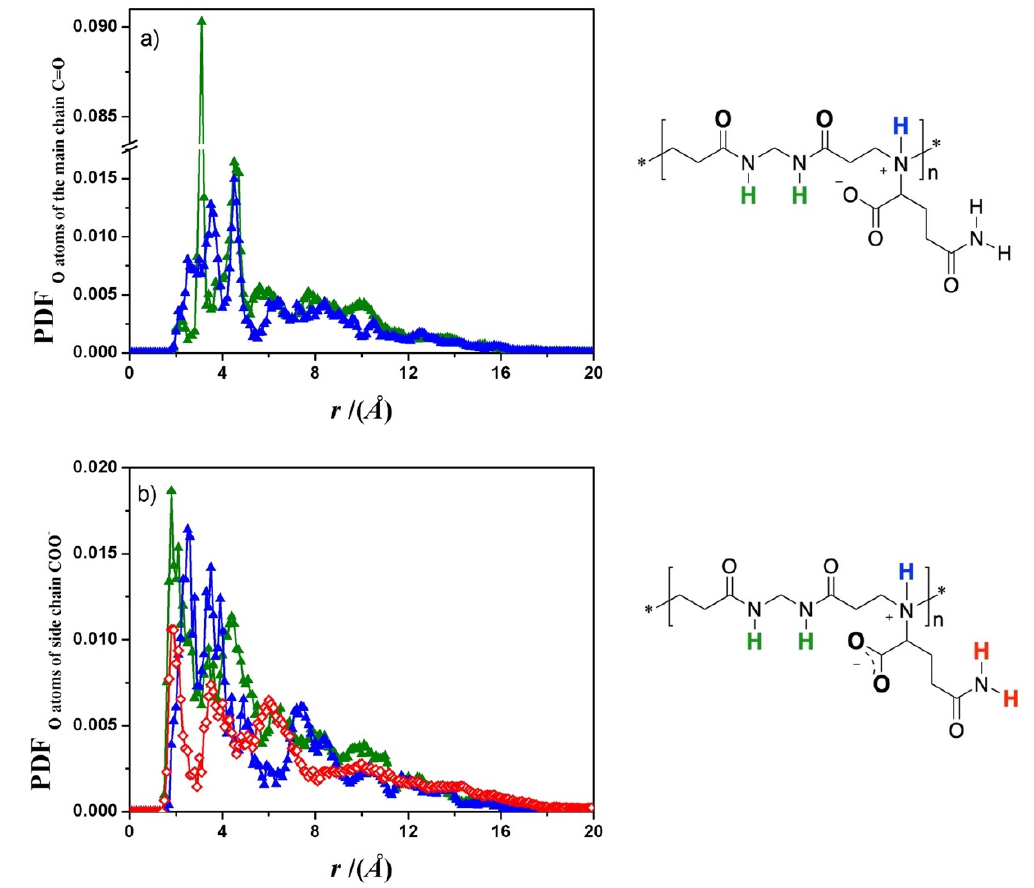
Figure 7. Pair distribution function (PDF) for M- l -Gln at pH 4.5. ( a ) Distribution of distances between the oxygen atoms of the main chain C = O: ( i ) the H atoms of the main chain amide groups (green); ( ii ) the H atoms of the protonated tert -amine groups (blue). ( b ) Distance distribution between the oxygen atoms of the carboxylate groups and ( i ) the H atoms of the main chain amides (green); ( ii ) the H atoms of the protonated tert -amines (blue); ( iii ) the H atoms of the amides in the side groups (red).